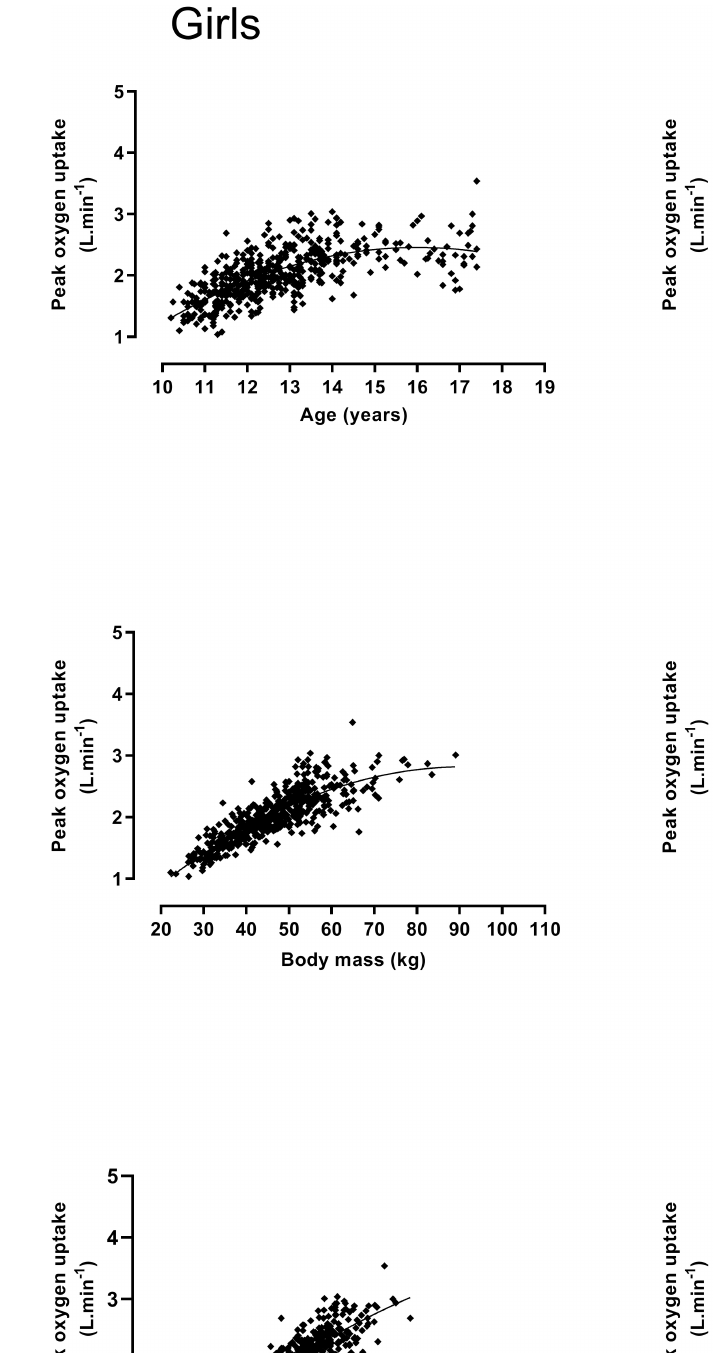
Frontiers in Physiology |